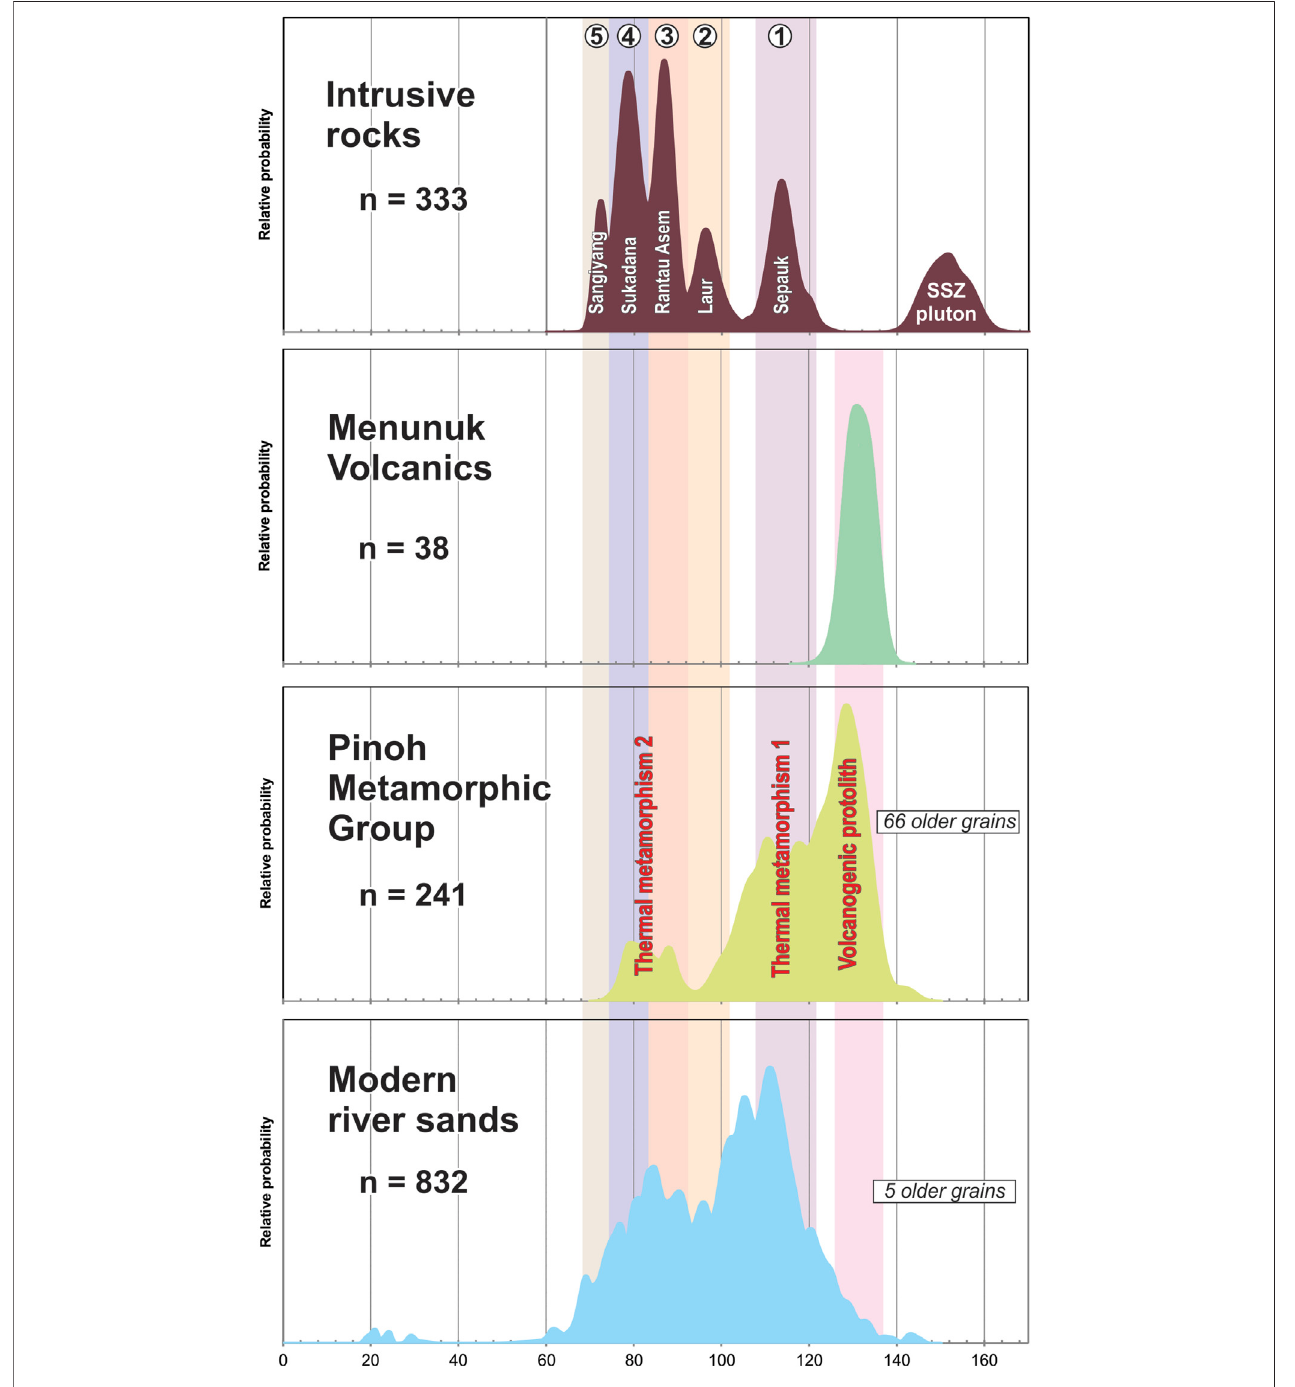
FIGURE 16 | Probability density summary of Cretaceous (to Jurassic) zircon populations for comparison. Intrusive rocks: 1) Sepauk Tonalite, 2) Laur Granite, 3) Rantau Asem Tonalite, 4) Sukadana Granite, and 5) Sangiyang Granite. Menunuk Volcanics correspond to the volcanogenic protolith of the PMG. Sepauk Tonalite correspondstothermalmetamorphismphase1)RantauAsemTonaliteandSukadanaGranitecorrespondtothermalmetamorphismphase2)Modernriversandsshow multiple age populations that correspond to the intrusive rocks with additional ages being derived from so far not discovered igneous rocks.